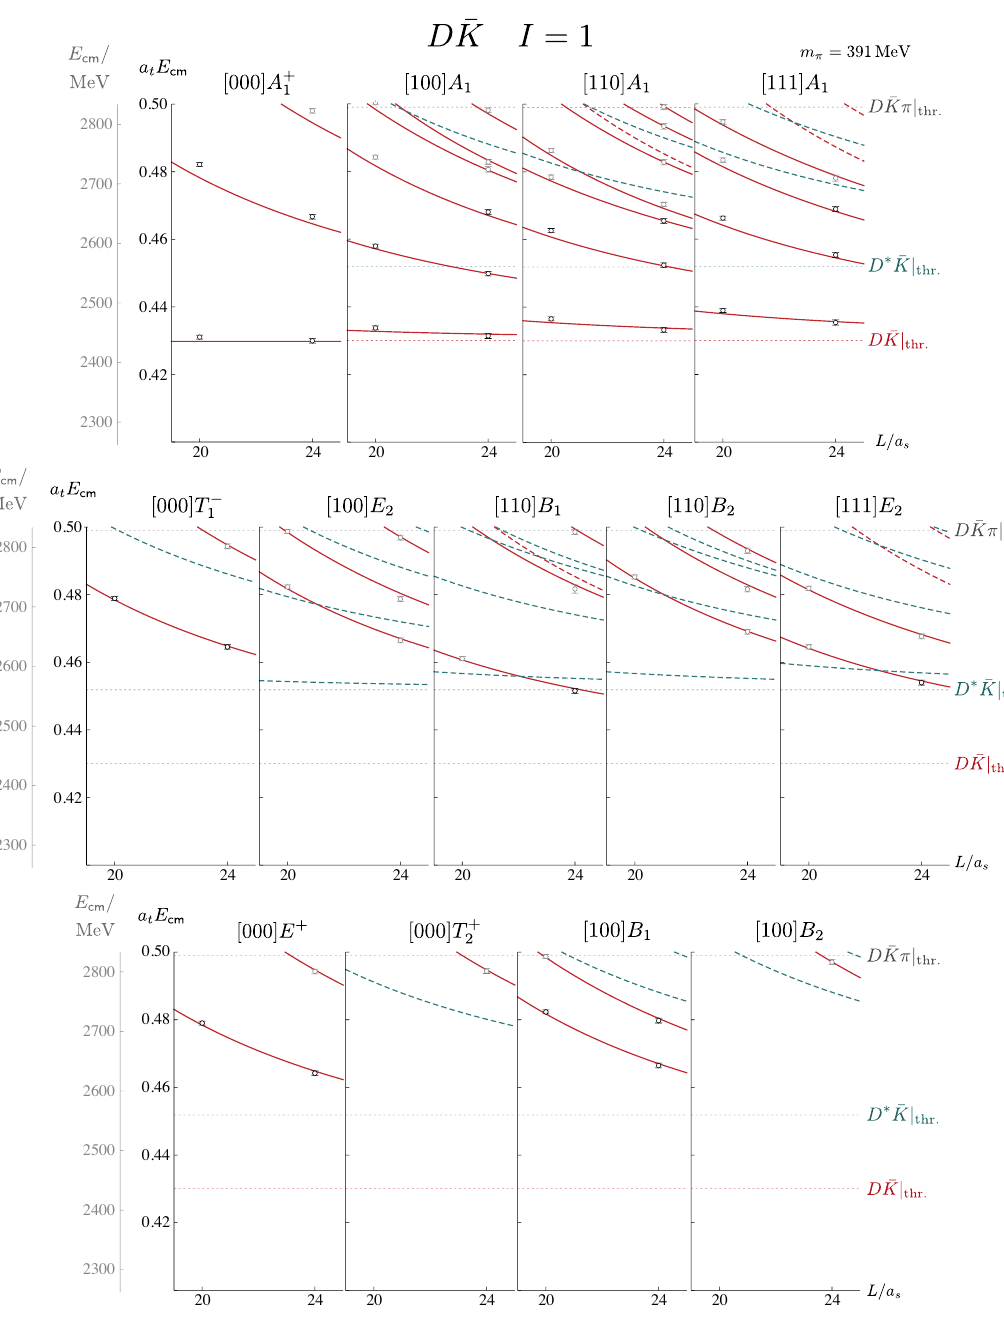
Figure 7 . As figure 3 but for I = 1 D ¯ K on the m π = 391 MeV